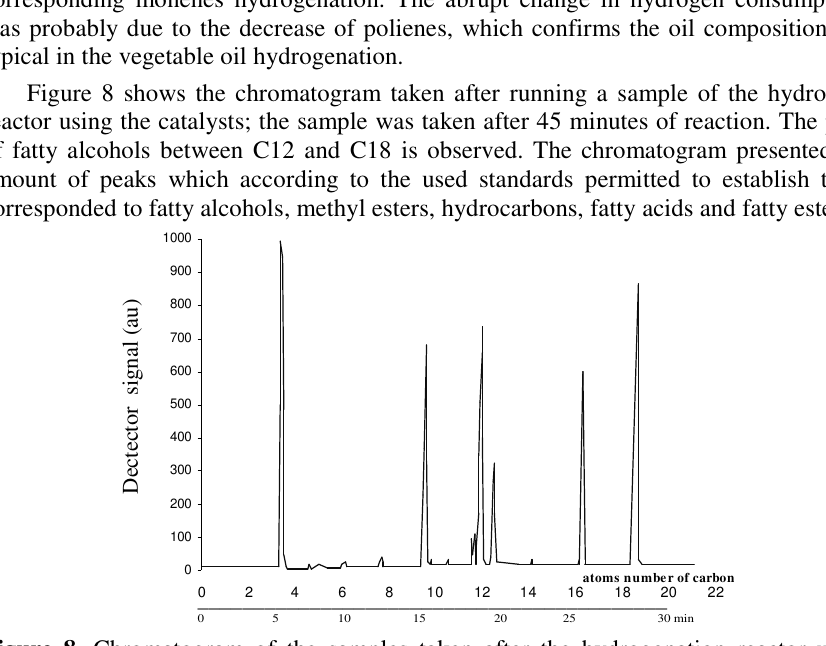
Figure 8. Chromatogram of the samples taken after the hydrogenation reactor using the bimetallic catalyst.